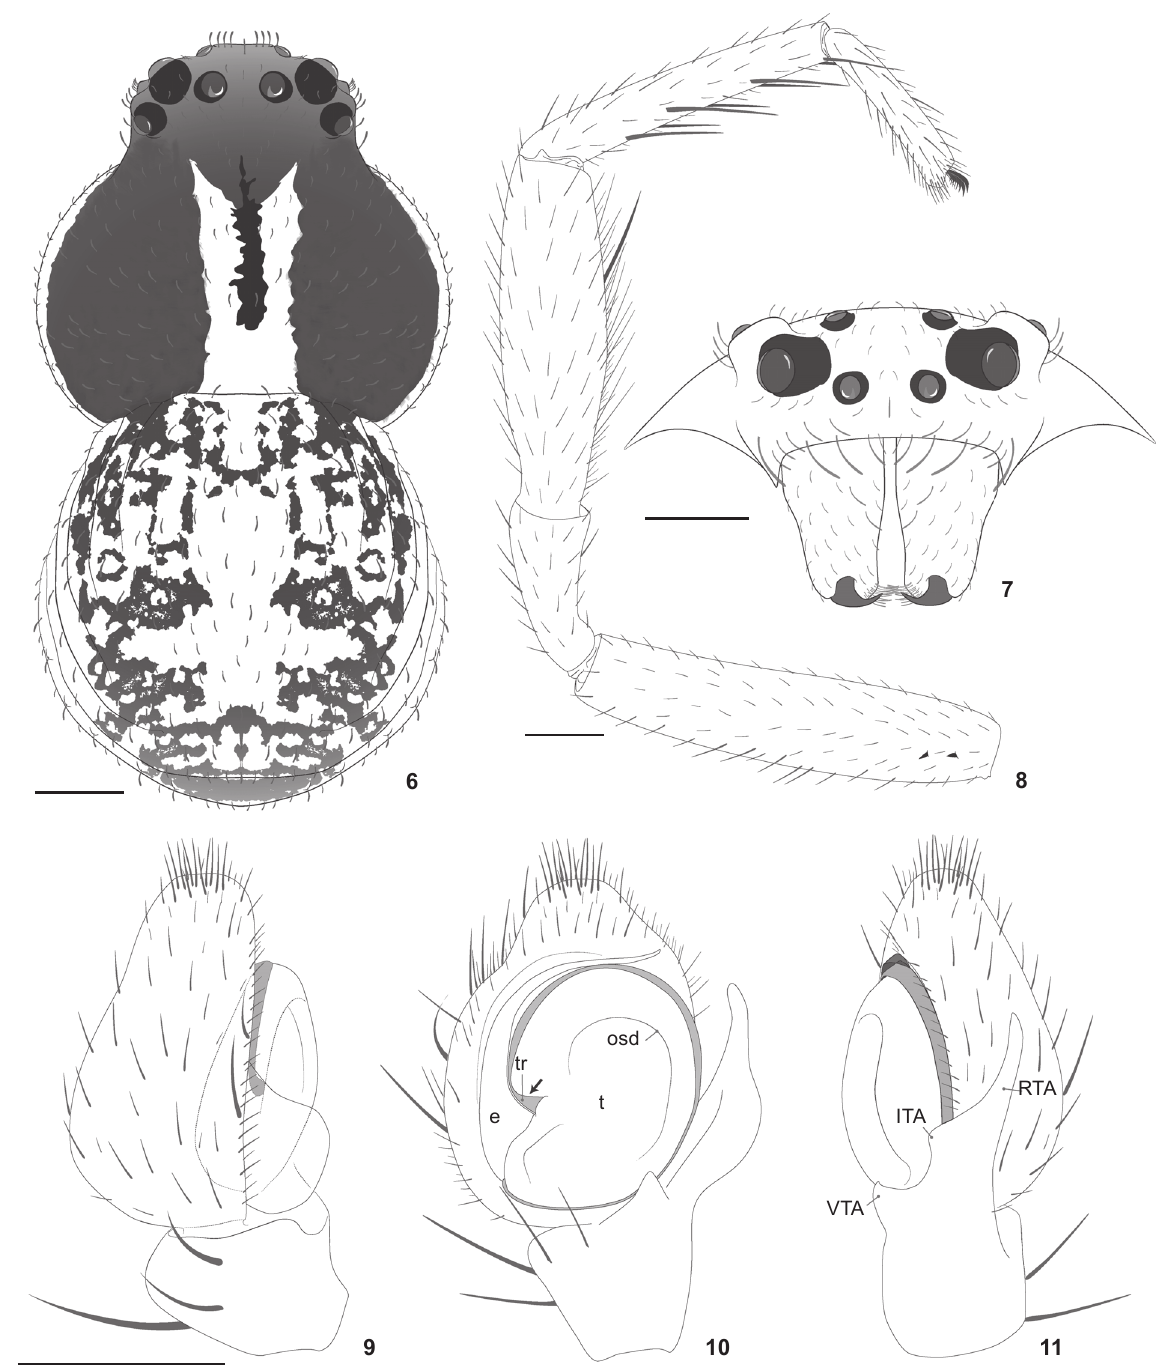
Figures 6-11. Misumenoides athleticus comb. nov. , male: (6) habitus, dorsal view; (7) carapace, frontal view; (8) left leg I, proloateral view; (9-11) male palp: (9) prolateral; (10) ventral; (11) retrolateral view. Scale bar: 0.25 mm. (e) Embolus, (ITA) intermediate tibial apophysis, (osd) outline of the sperm duct, (RTA) retrolateral tibial apophysis, (VTA) ventral tibial apophysis, (t) tegulum, (tr) tegular ridge. Black arrow indicates depression near the origin of tegular